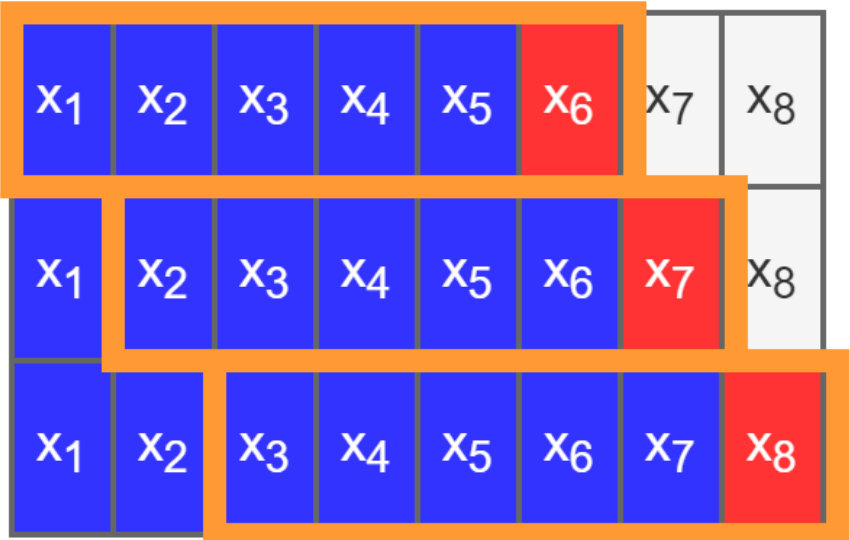
Figure 4. Illustration of the sliding window operation for LSTM on toy data. Blue boxes denoted as input data for LSTM, red boxes denoted as ground truth that needed to be predicted using LSTM, and orange rectangles are the sliding